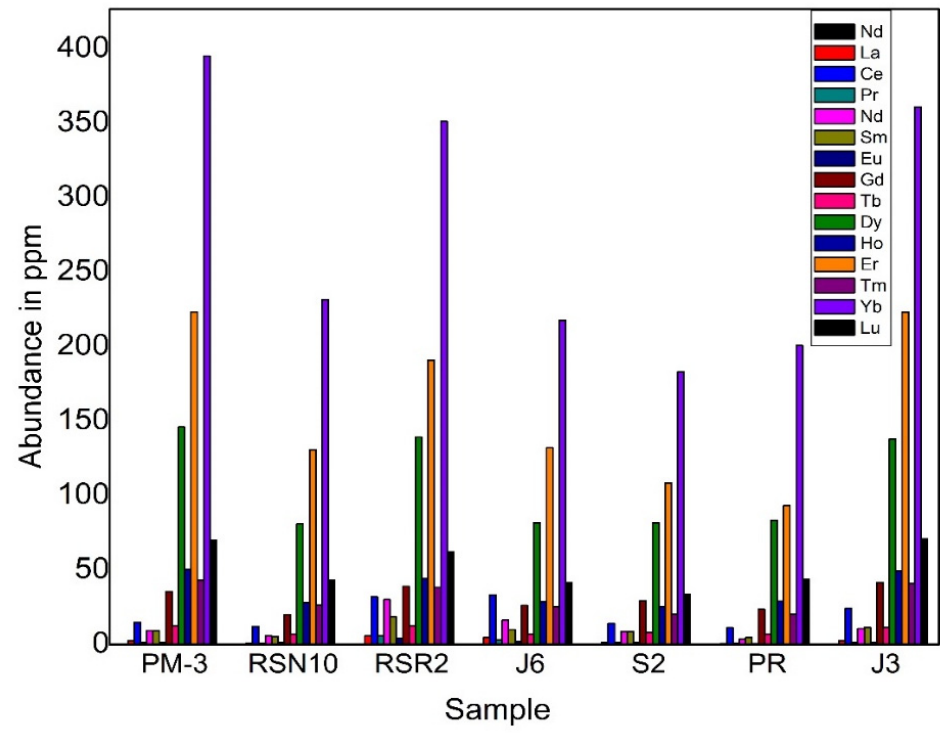
Figure 5. Abundance of REEs in zircon from different samples of sand.